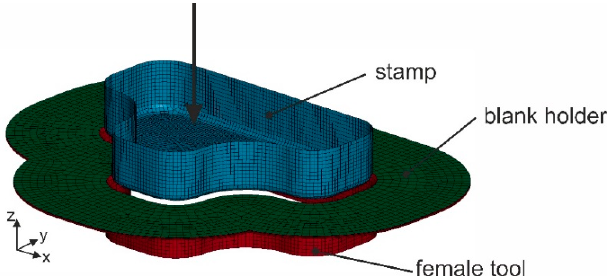
Figure 17. Model of the forming tool with T-shape geometry (arrow showing movement of the stamp).